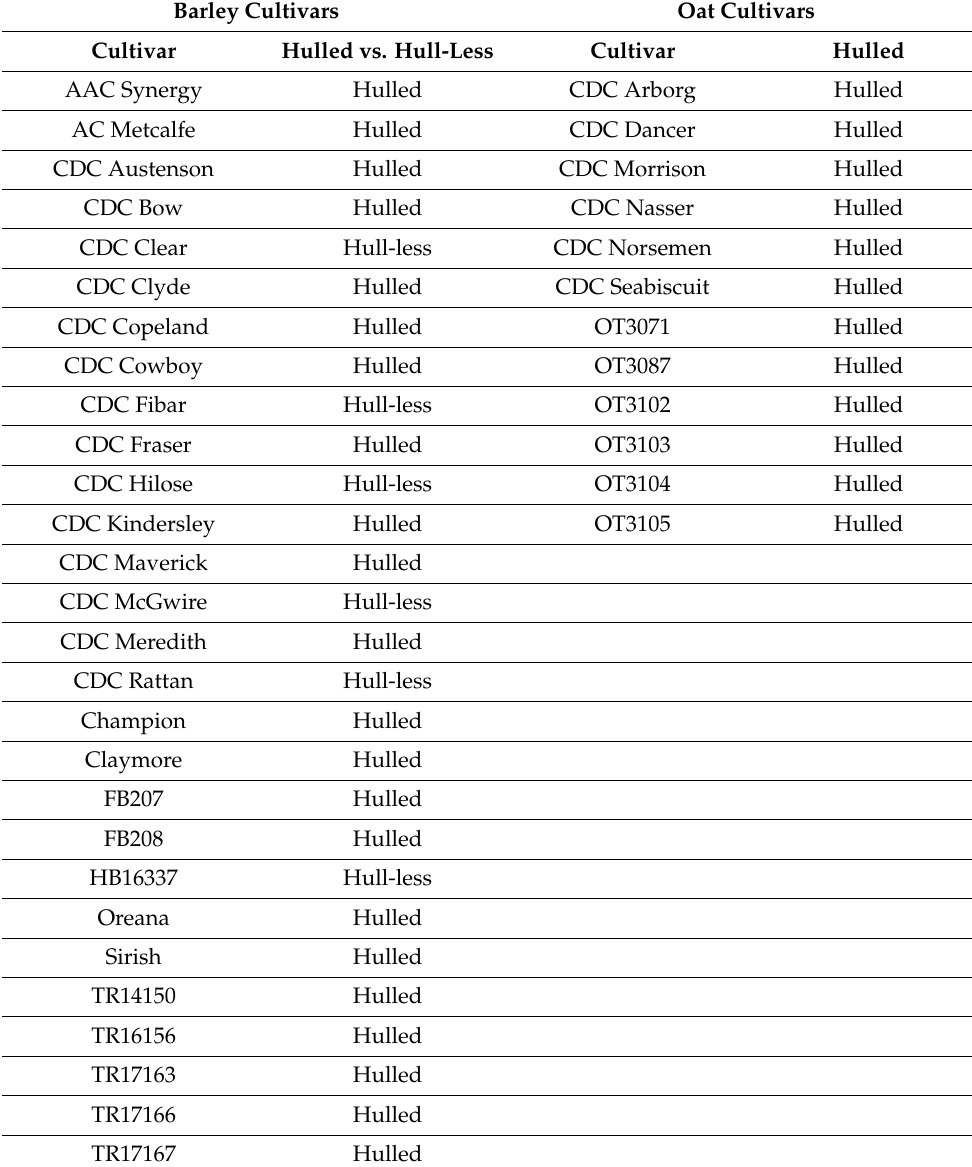
Table 1. Barley cultivars (28 cultivars; all 2-row except for 6-row CDC Clyde) and oats (12 cultivars) subjected to Saccharomyces cerevisiae